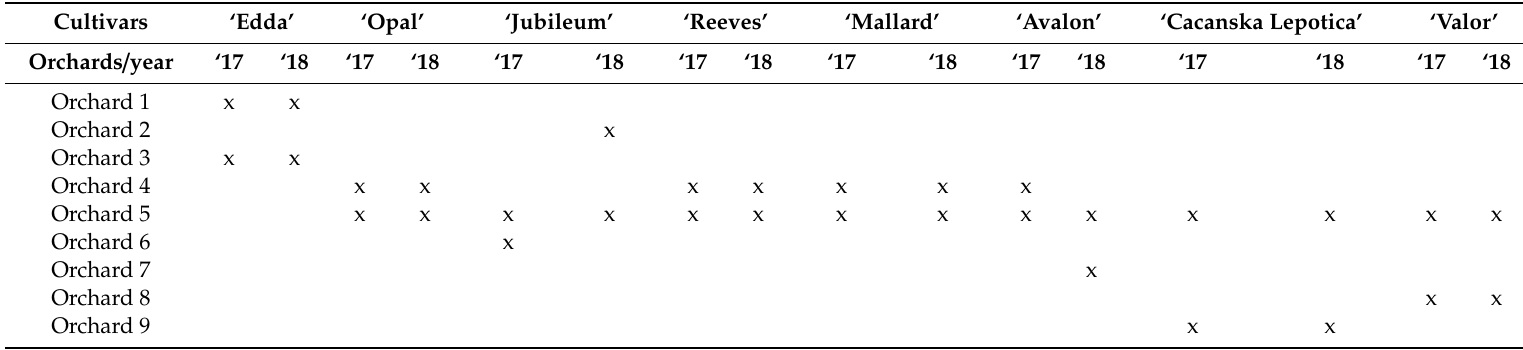
Table 1. Nine orchards, located in Ullensvang Norway, used to collect 480 fully open pollinated mature fruits from following plum cultivars: ‘Edda’, ‘Opal’, ‘Jubileum’, ‘Reeves’, ‘Mallard’, ‘Avalon’, ‘Cacanska Lepotica’, and ‘Valor’. Specific orchards sampled for each individual plum cultivar, for each of the investigated seasons, are marked in the